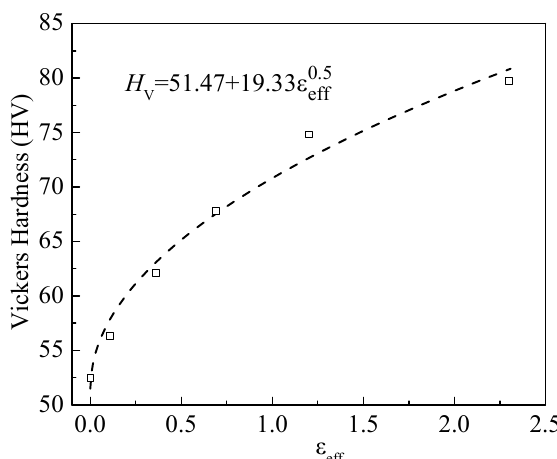
Figure 7. Dependence of Vickers hardness on effective strain for the as-annealed and cold-rolled specimens with the indentations performed at the normal load of 200 mN.